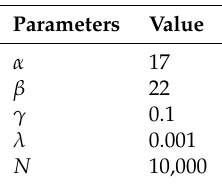
Table 2. The parameters of the proposed decision-control